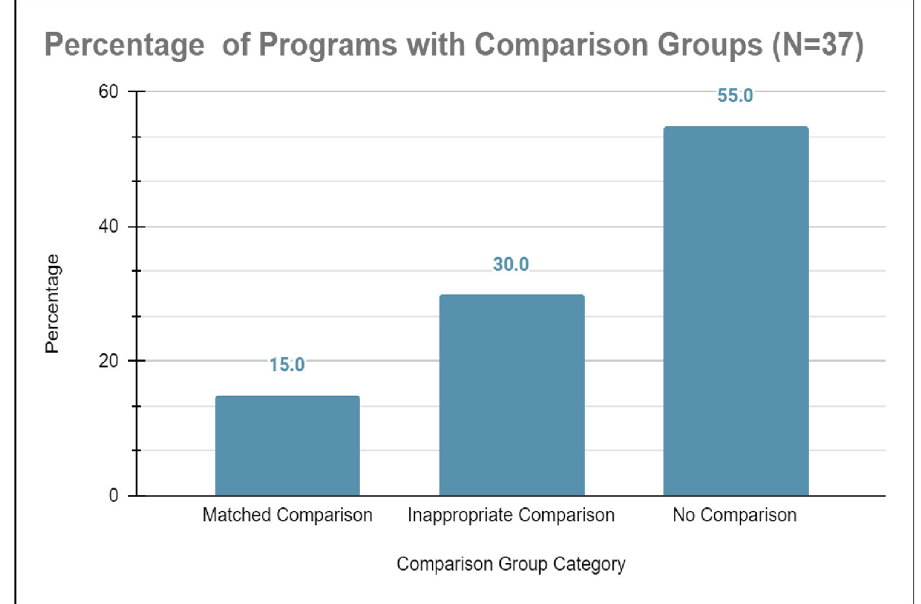
Fig 8. Of the N = 20, only 15.0% of programs studied correctly used a matched comparison group in their study design, 30.0% of programs studied erroneously used an inappropriate comparison group in their study design, and surprisingly 55.0% of programs studied neglected to use any comparison group in their study